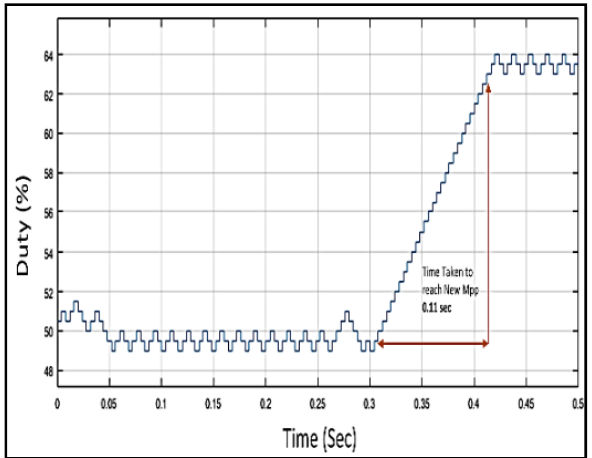
Figure 12. MATLAB Simulink model for hardware.